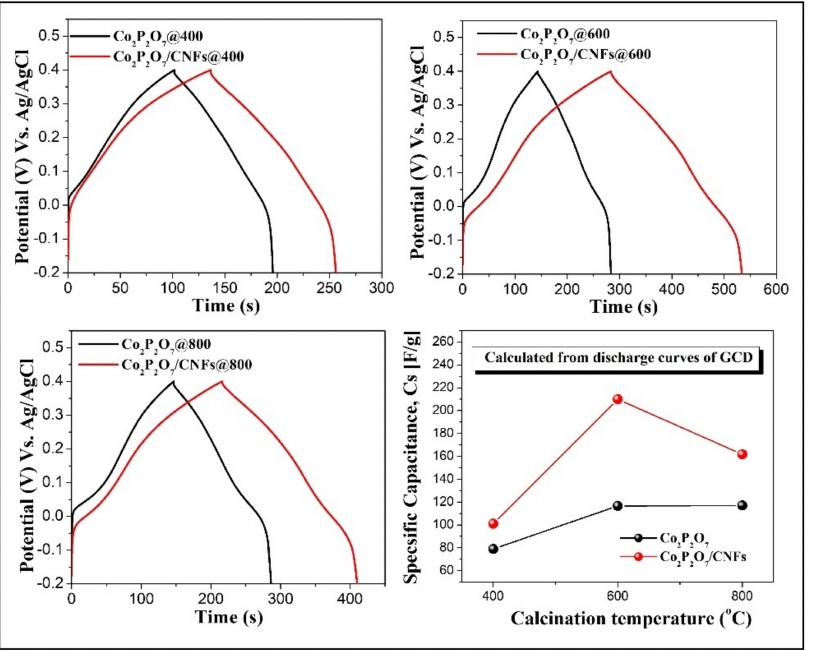
Figure 10. Comparative GCD curves at a current density of 0.5 A g − 1 with calculated specific capacitances of pure Co 2 P 2 O 7 versus Co 2 P 2 O 7 /CNFs calcined at 400 ◦ C, 600 ◦ C and 800 ◦ C under an argon